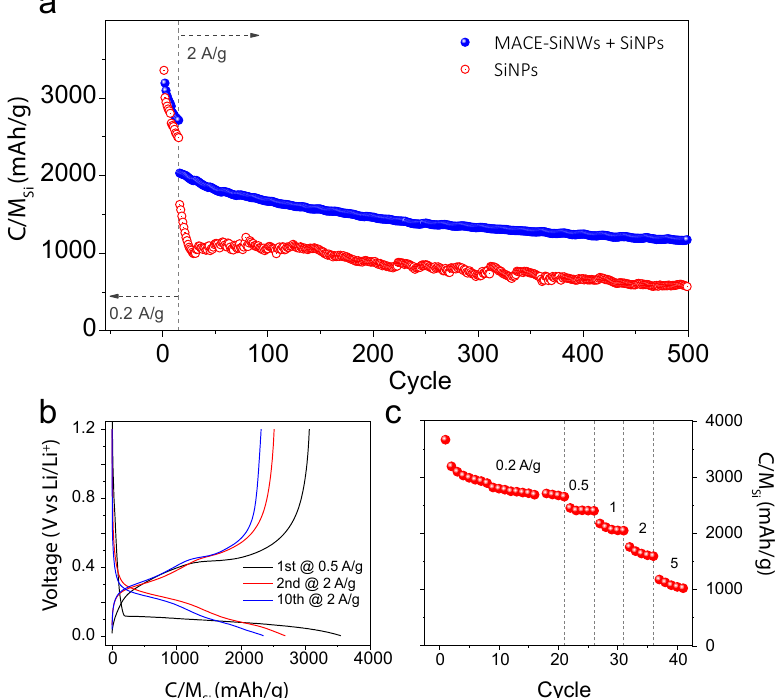
Figure 7. ( a ) Comparison between the cycling performance of the hybrid MACE-SiNWs/SiNPs and the SiNPs-US electrodes. ( b ) GCD curves of the hybrid electrode, and ( c ) shows the rate performance of the hybrid